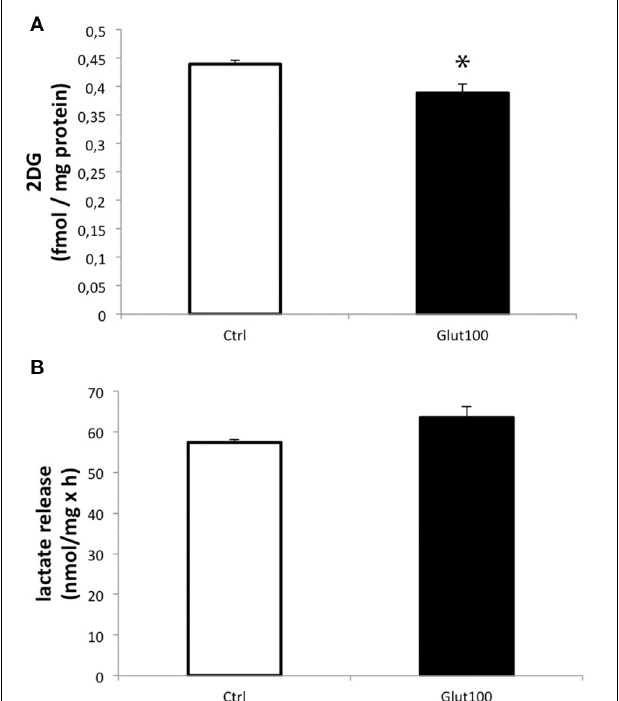
FIGURE 1 | Effect of glutamate on glucose utilization and lactate production in cultured rat hippocampal neurons. (A) [ 3 H]-2-deoxyglucose uptake and accumulation was measured in primary cultures of rat hippocampal neurons for 20min either without exposure to glutamate (Ctrl) or with prior treatment with glutamate 100 μ M for 1h followed by the presence of the same concentration of glutamate during the [ 3 H]2DG uptake measurement (Glut100). (B) Lactate production and release was measured in primary cultures of rat hippocampal neurons for 20min either without exposure to glutamate (Ctrl) or with prior treatment with glutamate 100 μ M for 1h followed by the presence of the same concentration of glutamate during the lactate production measurement (Glut100). Data represent mean ± SD with n = 3. Statistical analysis was performed using a non-parametric Mann–Whitney test. An asterisk indicates 2DG uptake significantly different from control with p < 0 . 05. 2DG, 2-Deoxyglucose; CTRL,